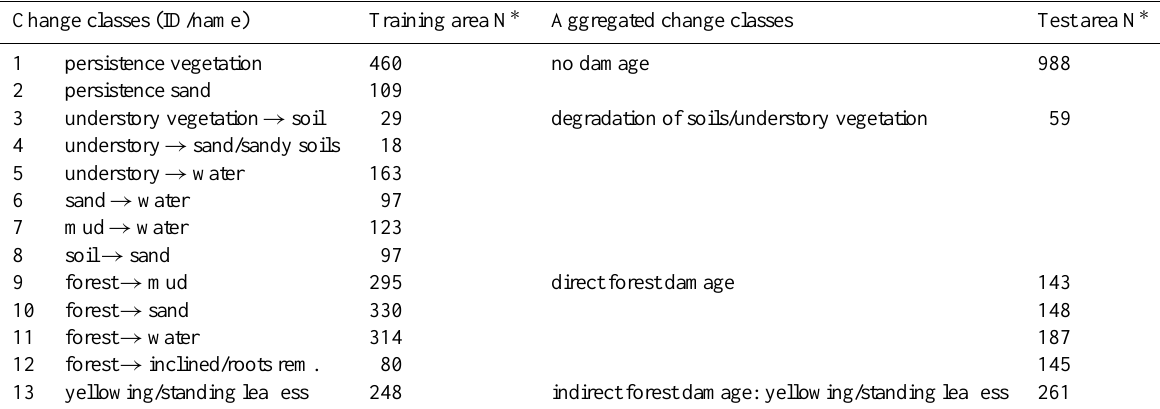
Table 2. Training and test area for DMC.